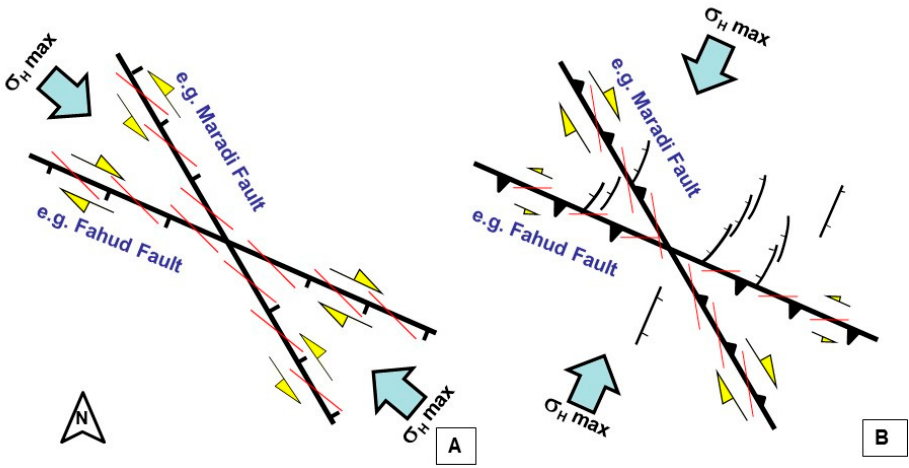
Figure 4. Map-view illustrations of the stress regimes during: ( A ) Late Cretaceous, ( B ) Late Cenozoic, and the types of faults that developed and were reactivated in both times [3].